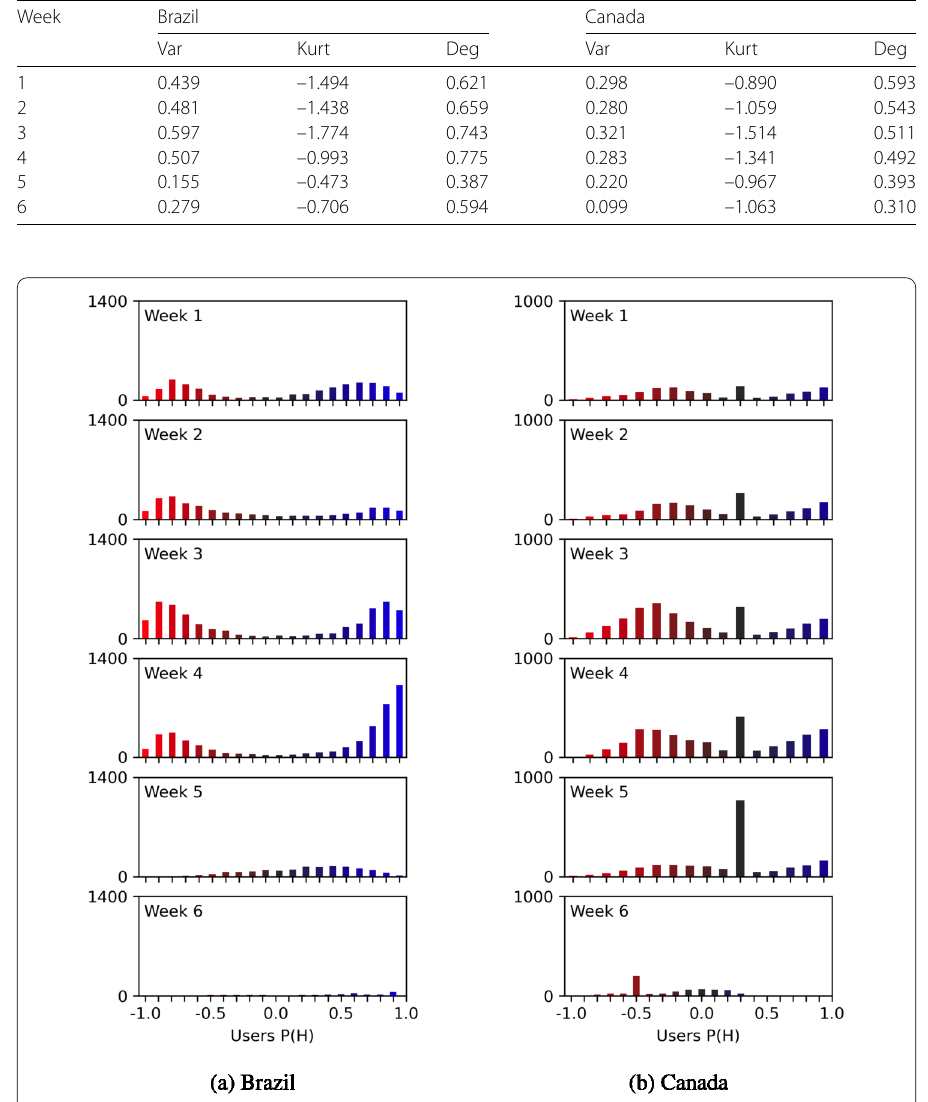
Figure 4 Number of users by polarity histograms